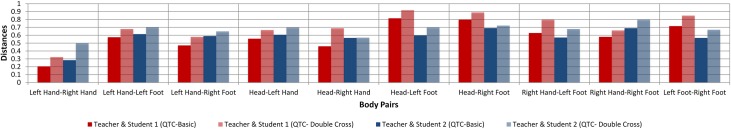
A sample assessment of the performances of the samba students.